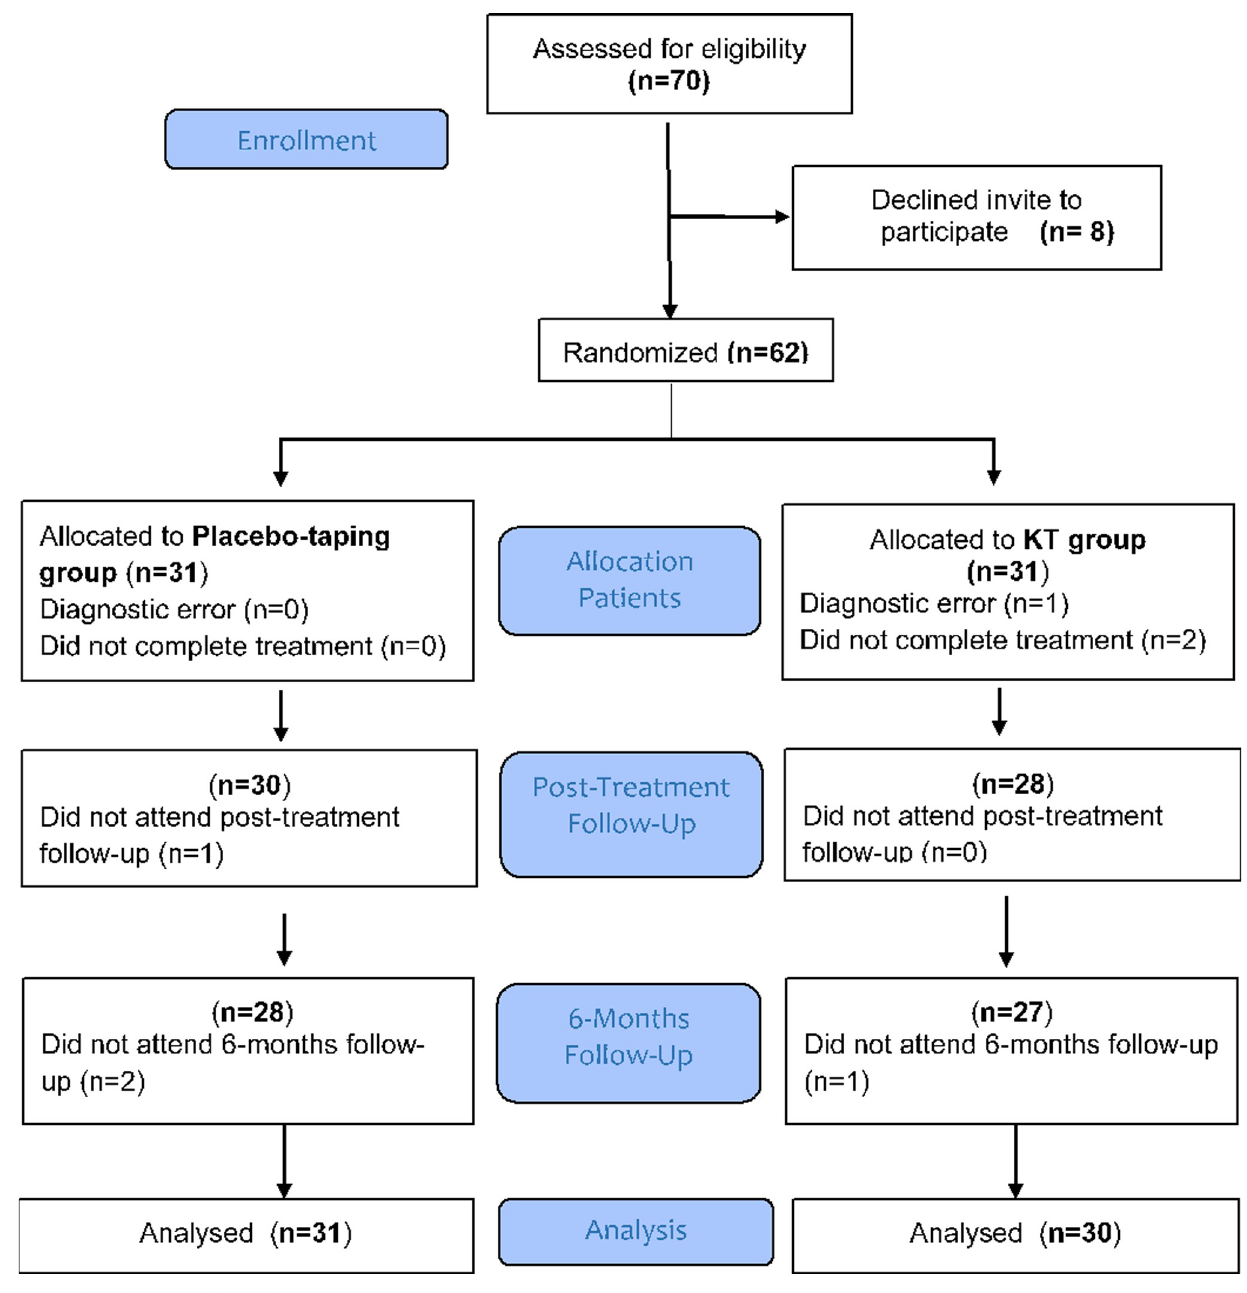
Fig 1. Flow diagram of the